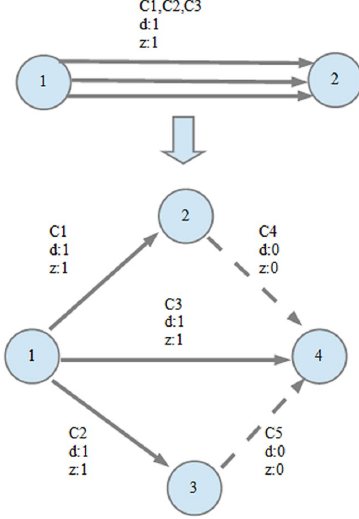
Fig. 5. Network 2